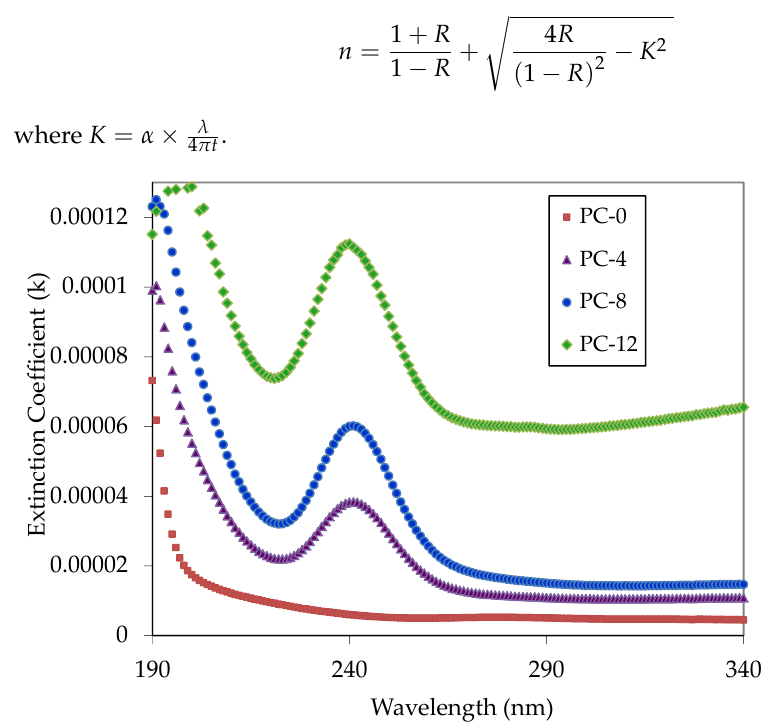
Figure 14. Extinction coefficients ( k ) over a broad wavelength range.